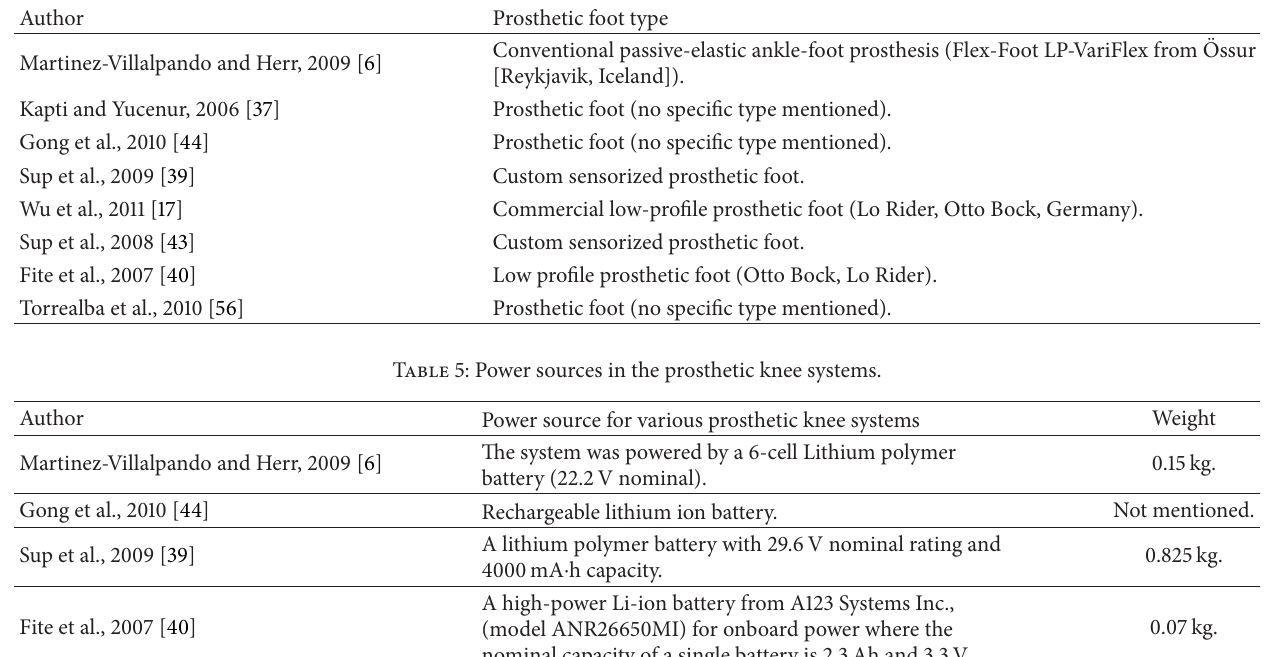
Table 4: Prosthetic foot devices in the prosthetic knee systems.